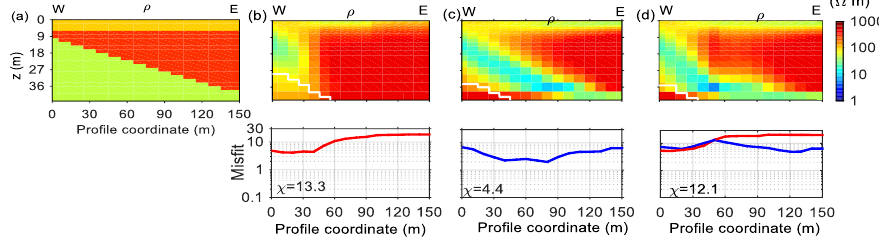
Figure 7. Comparison between the true resistivity value ( a ) and resistivity inversion results of the IP responses of the strong chargeable medium: by x -data only ( b ); z -data only ( c ); and x and z data ( d ). White line shows the DOI curve and circles the areas of the models below the DOI, while red and blue curves represent the misfits of x data and z data.